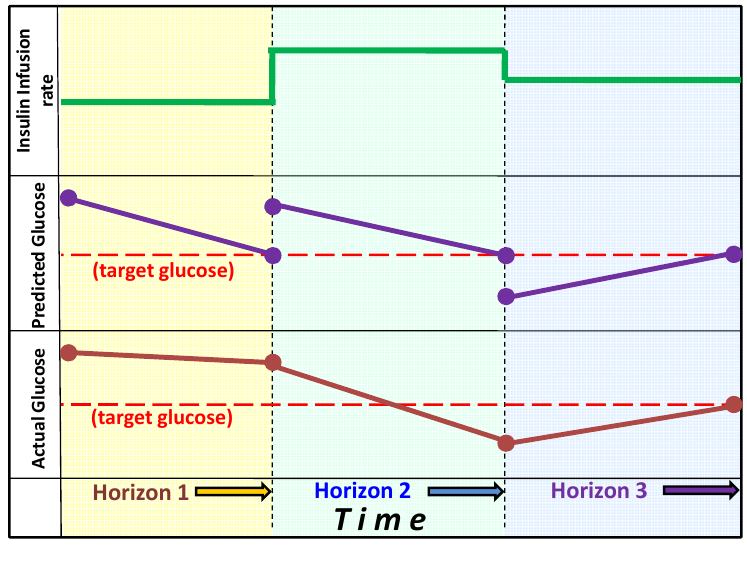
Figure 2. Model Predictive Control: The graph shows the change in actual glucose, the model-predicted change in glucose and the insulin infusion rates during three horizon segments. Upon reaching the first horizon actual glucose fails to decline to the predicted target, thus the insulin infusion rate is increased (for example by lowering the estimate for insulin sensitivity). At the second horizon, glucose has declined below the target, thus insulin infusion rate is reduced. At the third horizon on the actual glucose has reached the predicted target value and the estimate of insulin sensitivity remains